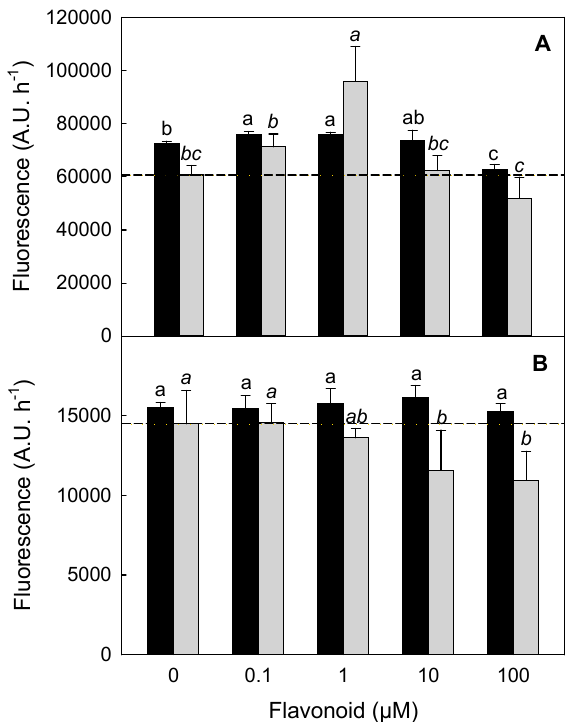
Figure 5. QC and CA modulation of the chitinase activity of S. griseus and RGSM enzyme. Chitinolytic